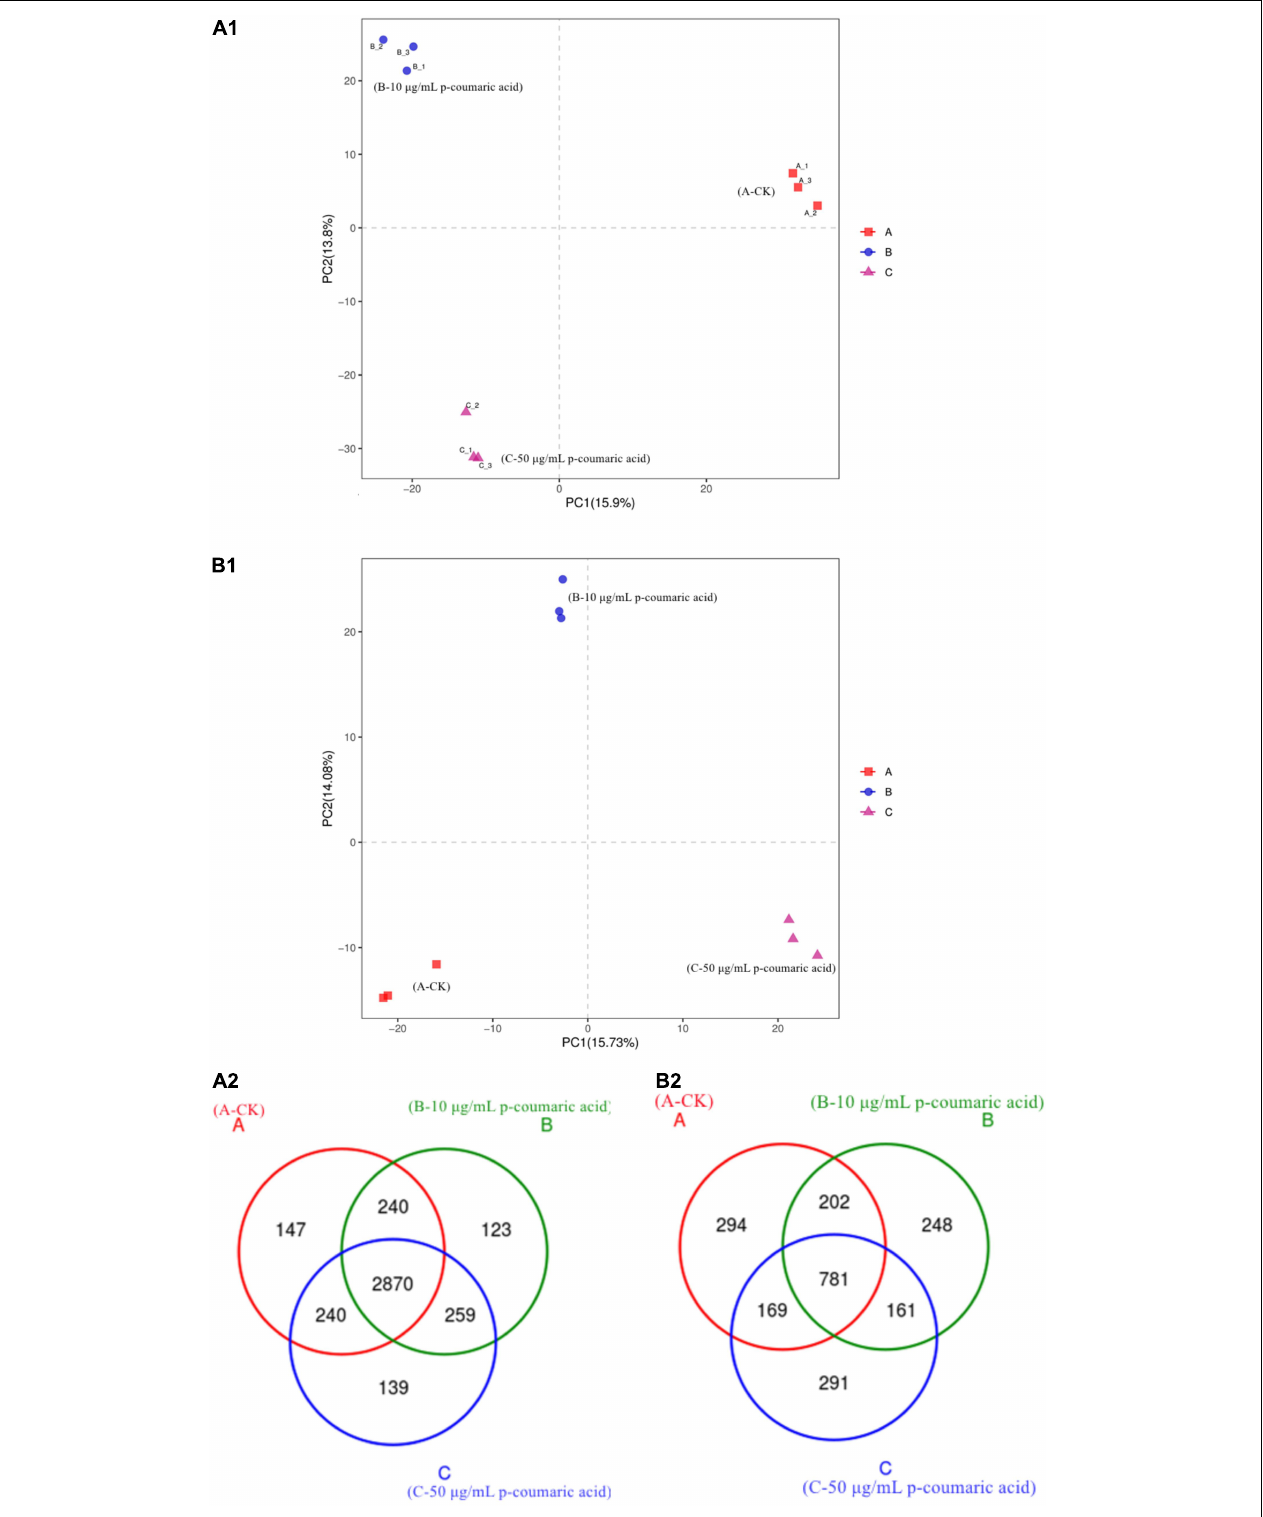
FIGURE 10 | Alfalfa rhizosphere with adding p-coumaric acid’s principal coordinate analysis (PCoA). (A1) Bacteria and (B1) fungi. (A2) Venn diagram of bacteria, and (B2) Venn diagram of fungi.